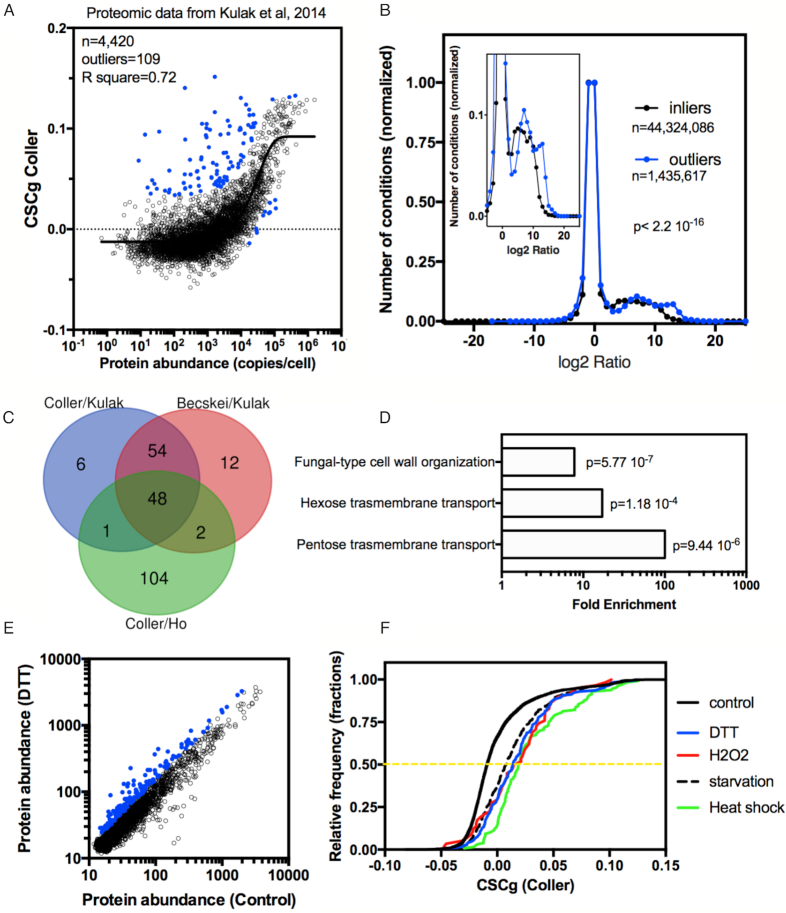
Correlation between CSCg and the protein copy number in S. cerevisiae. (A) The best-fit curve was used to calculate the correlation among the CSCg values (Coller's dataset) and the protein abundance (Kulak's dataset) (40). Outliers are highlighted in blue. (B) Plot showing the distribution of genes according to their expression regulation under 400 different experimental conditions (data obtained from the SGD). The inlier genes are shown with a black line, and outlier subsets of genes are shown with blue lines. The inset shows the overexpressed population on a different scale. Note that the outliers presented higher induction levels and were overexpressed in more conditions than the inlier group. The P-value was calculated with the Kolmogorov–Smirnov test (Supplementary Table S5B). (C) The same analysis described in panel A was performed to compare other datasets (i.e. CSCg values from Coller's dataset vs protein abundance from Ho's dataset (41) (Supplementary Figure S6) and CSCg values from Becskey's dataset versus protein abundance from Kulak's dataset (Supplementary Figure S5)). The Venn diagram of outliers identified in these three analyses showed 48 genes in common. (D) Gene ontology of the 48 genes identified in panel C. For the subsequent experiments, we analyzed a different subset of proteins that were upregulated under different stress conditions. (E) As an example, we show the correlation plot used to select the subset of proteins induced by DTT (43). Proteins with an induction level of more than 1.5-fold were selected (blue dots). (F) Cumulative distribution of the CSCg values of genes coding the proteins induced more than 1.5-fold by different stresses (43) was compared to that of all genes (control). The p-value calculated with the Kolmogorov–Smirnov test was <0.0001 for each stress condition analyzed versus the control (see statistical details in Supplementary Table S5B).